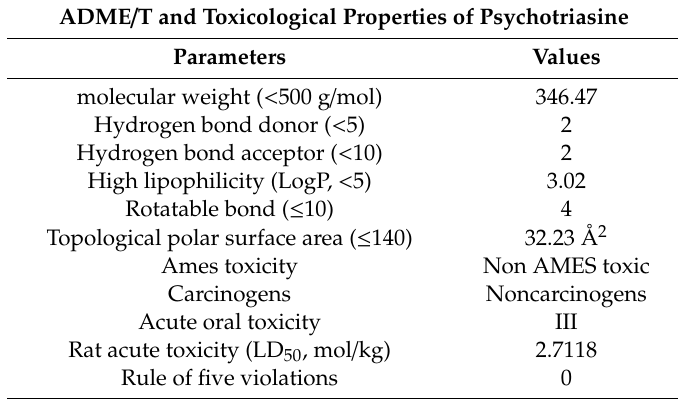
Table 6. ADME / T and toxicological properties of psychotriasine isolated from the P. calocarpa. ADME / T and Toxicological Properties of